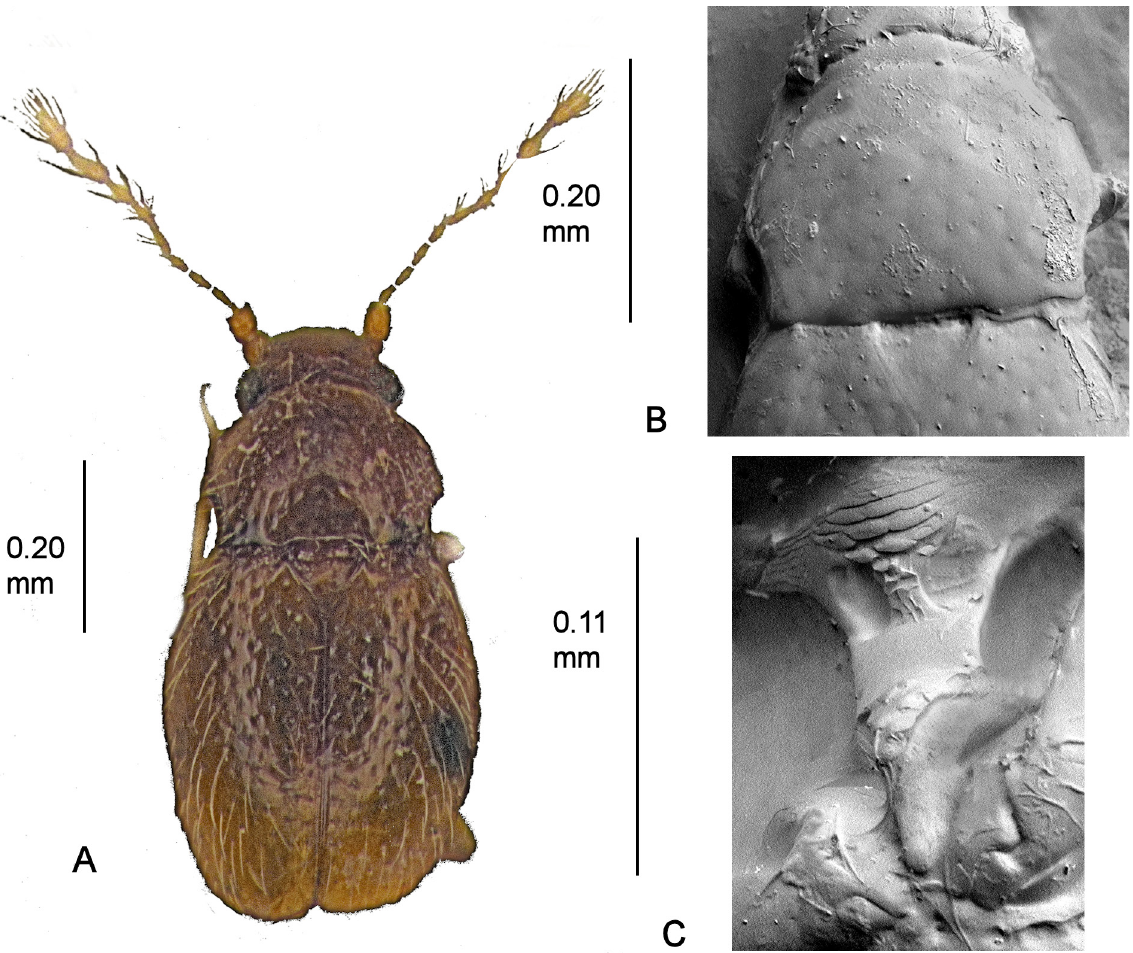
Fig. 89 . Cissidium bomjesus sp. nov. A . Habitus. B . Pronotum, × 570. C . Mesoventrite showing median process of collar, mid-keel and keel, ×